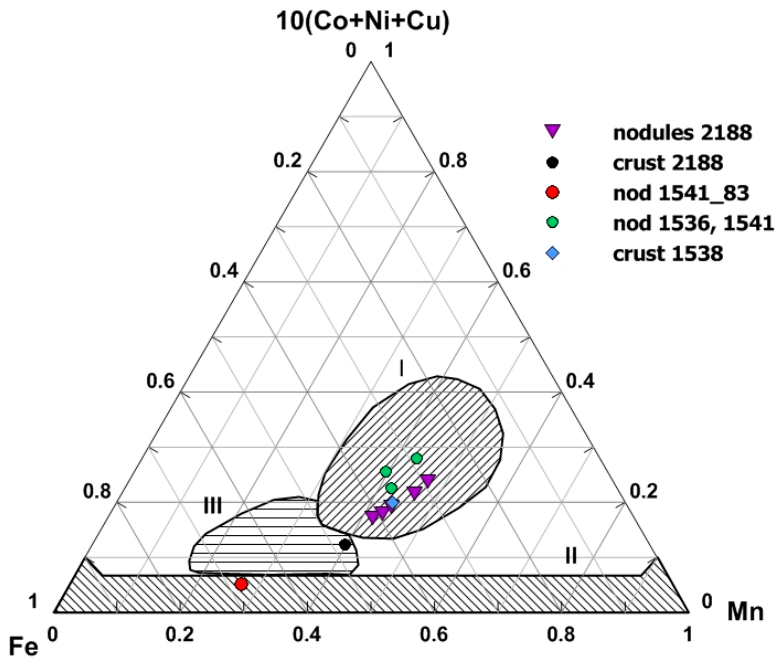
Figure 5. Ternary diagram of Bonatti et al. [40] showing nodule composition in Fe–Mn-10 × (Co + Ni + Cu) coordinates: ( I ) Field of deep-sea pelagic nodules and hydrogenous crusts; ( II ) field of hydrothermal Fe–Mn deposits; ( III ) field of hydrothermal metalliferous sediments and diagenetic nodules, from the margins of the oceanic pelagic zone.